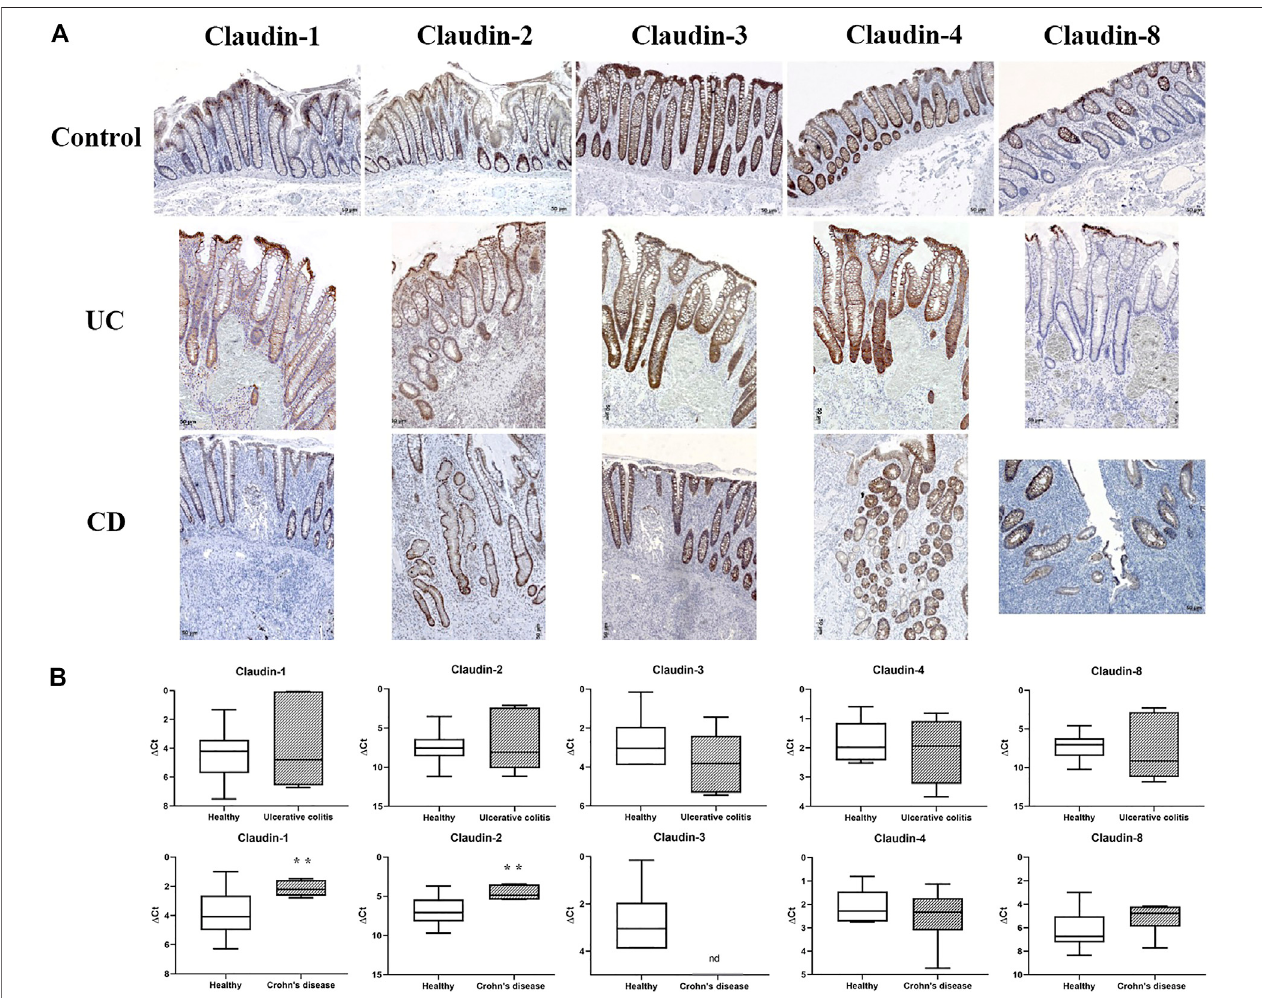
FIGURE 1 | Claudin-1, claudin-2, claudin-3, claudin-4, and claudin-8 expression in control human colon and colon of IBD patients. (A) Overview of claudin-1, claudin-2, claudin-3, claudin-4, and claudin-8 expression pattern (IHC); (B) claudin mRNA expressed as Δ CT value from claudin CT normalized to the GAPDH CT. Data arepresentedasbox-and-whiskerplots,withmedianandwhiskersextendingfrom5to95percentiles(eightnon-IBD, fi veUC,andeightCD).ND,belowdetectionlimit. t Test, p < 0.05 vs. non-IBD; CD, Crohn disease; UC, ulcerative colitis.